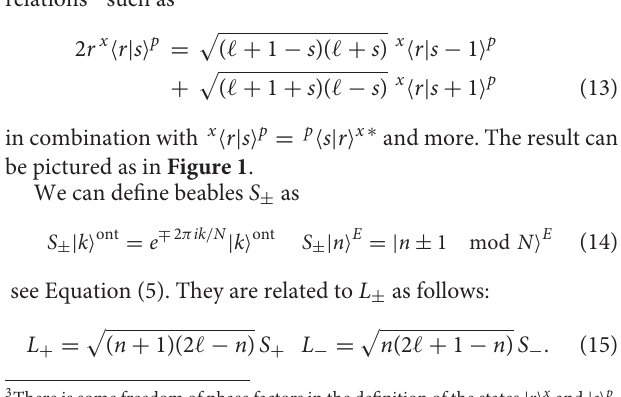
FIGURE 1 | The matrix (12), for the case ℓ solution for the matrix elements are shown. Black is maximal, gray is minimal. Notice that, these elements quickly converge to zero outside the m ′ 2 ℓ 2 (obtained using Mathematica to integrate Equation (13)). circle m 2 + =